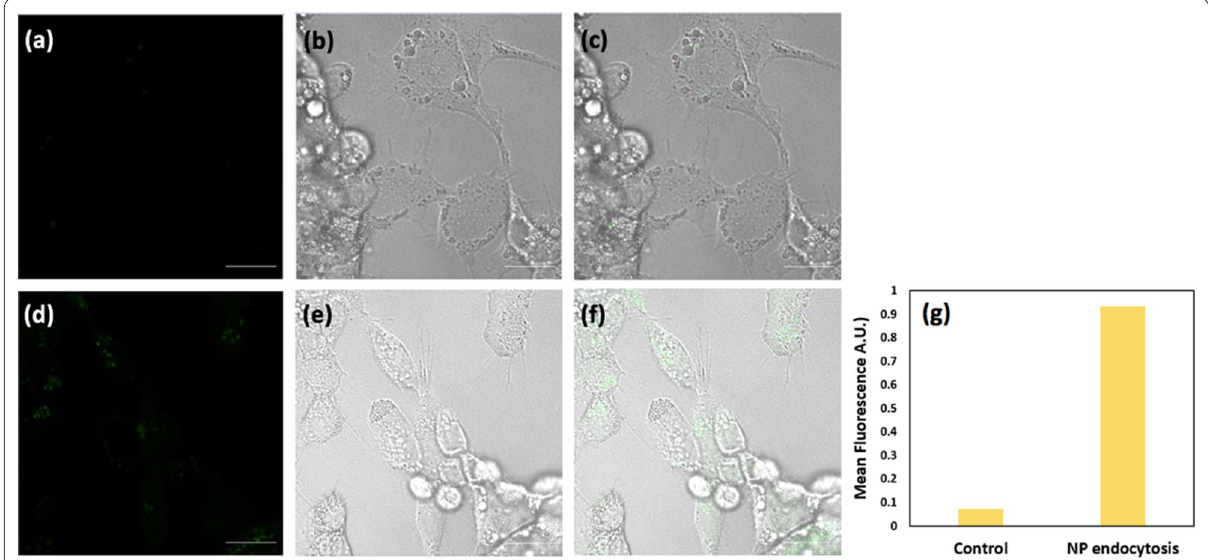
Fig. 6 Optical confocal images. The a , d fluorescence, b , e BF and c , f composite optical images of the HepG2 cells incubated with and without the fNPs, as the corresponding experimental and control groups, are presented in the a – c top and d – f bottom rows alongside g a histogram of the average fluorescence intensities. Scale bars represent 20 μm; the laser excitation wavelength is 488